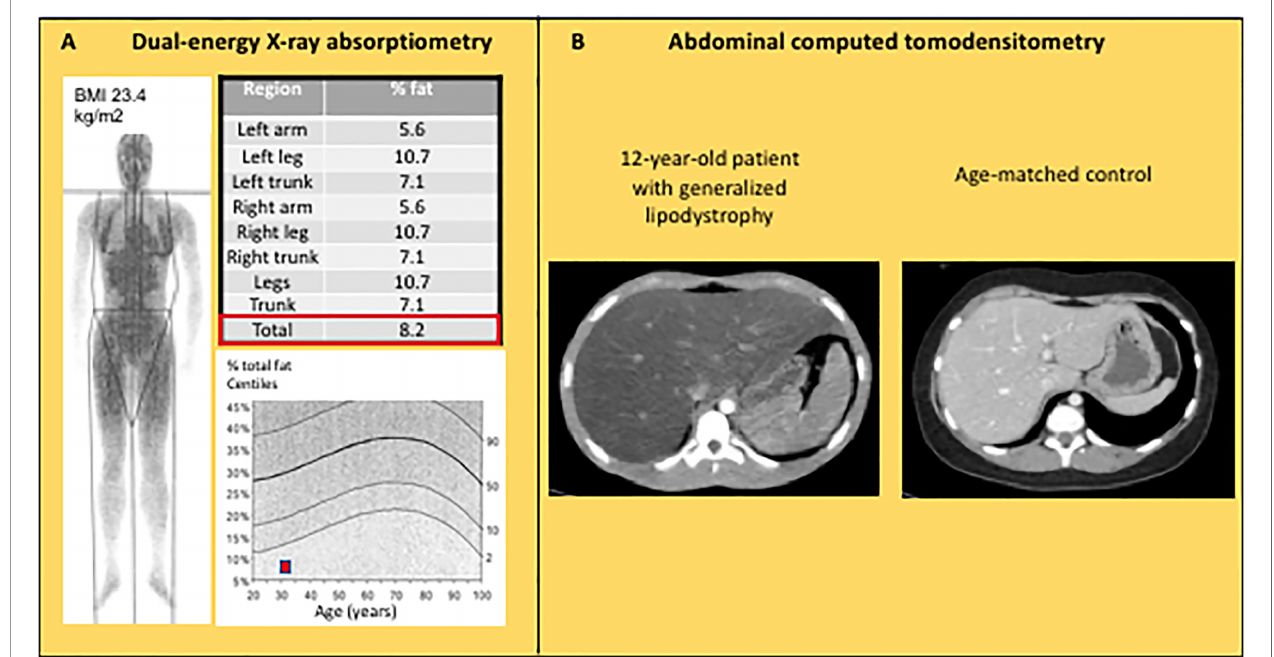
FIGURE 4 | Imaging features in lipodystrophy syndromes. (A) Dual energy-ray absorptiometry (DEXA) in a 31 year-old patient with CGL1, showing a major decrease in total and segmental fat mass. (B) Abdominal computed tomodensitometry in a 12 year-old patient with acquired generalized lipodystrophy showing homogeneous hepatomegaly with low attenuation of the parenchyma (Houns fi eld units: -13), and absence of subcutaneous adipose